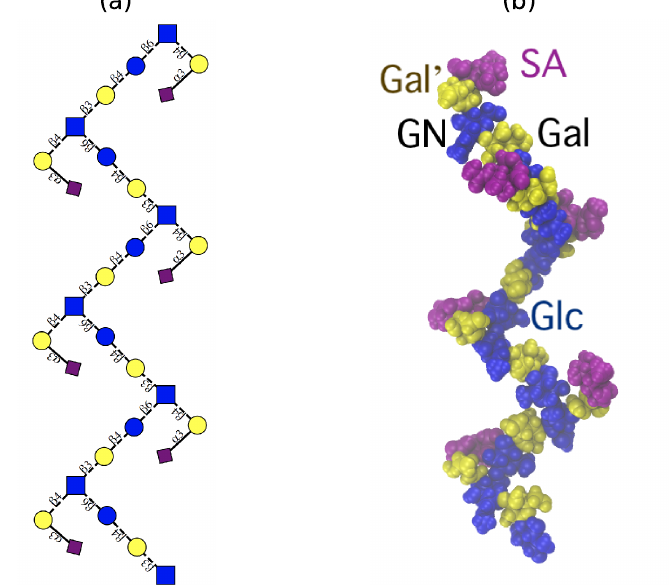
Figure 3. The ‘zig-zag’ conformational habit of GBSIII and Pn14 PS. ( a ) Schematic representation with the ESN symbol set [16] (yellow circle: Gal, blue circle: Glc, blue square: GlcNAc, purple diamond: Neu5Ac) and ( b ) a representative 6RU GBSIII PS simulation snapshot. Residues are highlighted as follows: Glc and GlcNAc: blue; Gal: yellow; sialic acid: